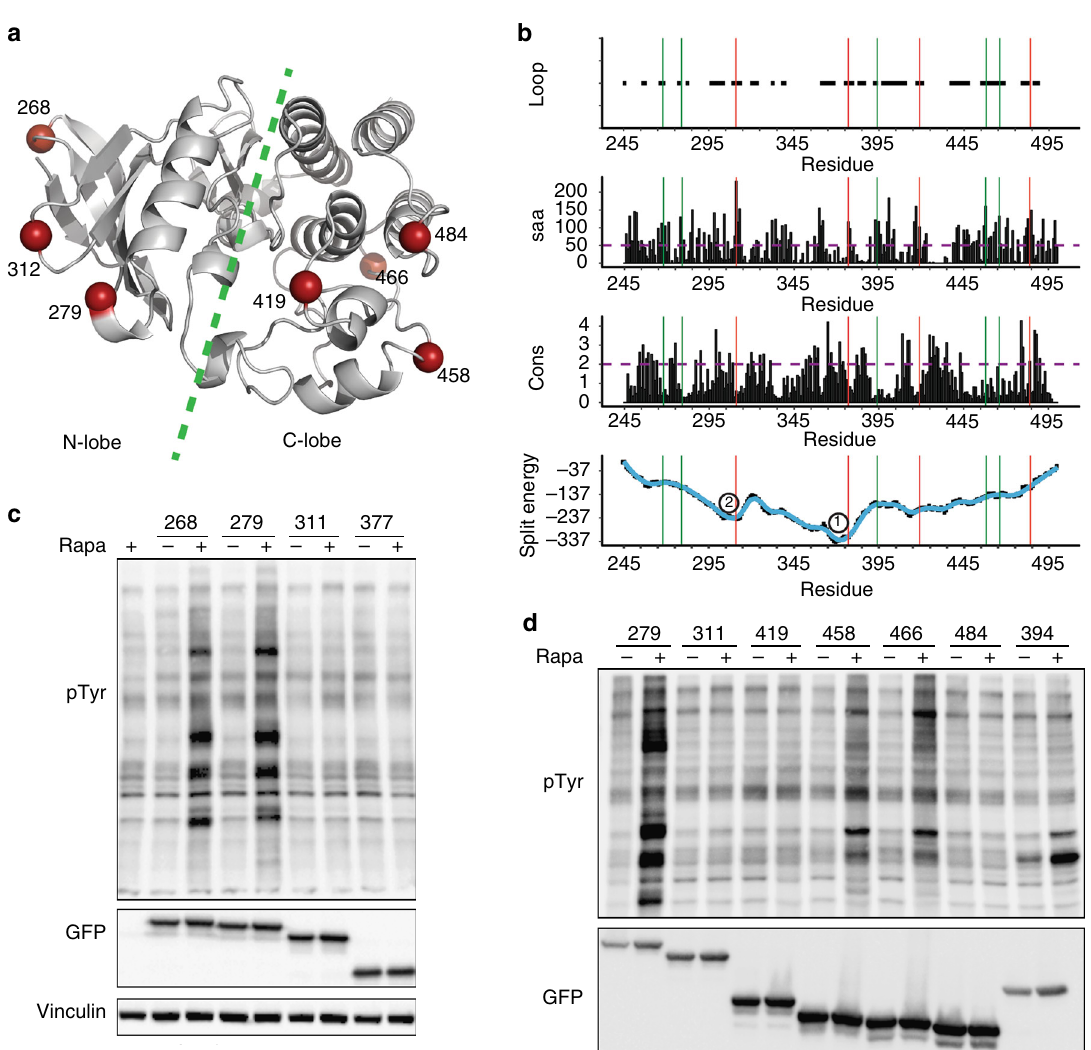
Fig. 2 Lyn SPELL. a The structure of Lyn with split sites shown in red. b Based on the SPELL algorithm, we selected sites to test, including the promising residues 268 and 279, substantially higher in split energy than the cores at 1 and 2. 393 is a previously reported split site. c Phosphotyrosine blot of cell lysates with Lyn analogs split at N-lobe of the kinase domain. d Phosphotyrosine blot of cell lysates, including Lyn analogs split at C-lobe of the kinase domain. GFP is fused to the C terminus of Lyn to show the expression of full-length Lyn or C-lobe split